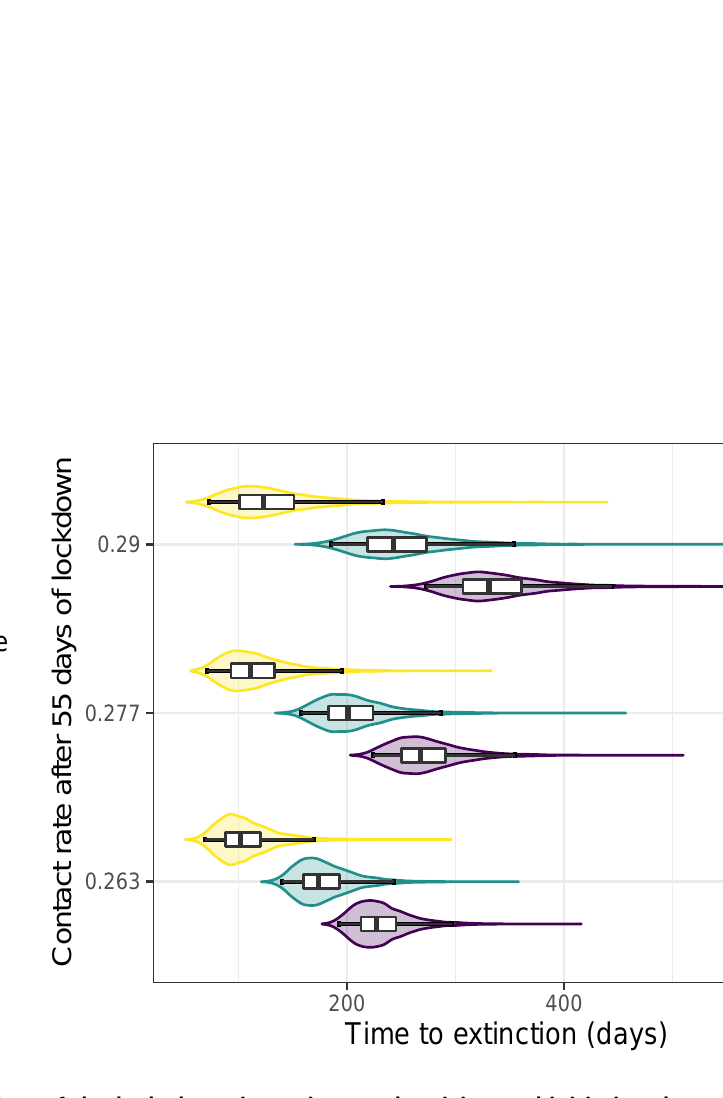
Figure S8 – Effect of the lock-down intensity, stochasticity, and initiation date on the time to extinction ( τ ) without individual spreading heterogeneity assumption. The dis- tributions of the time to extinction (in days since the start of the lock-down) for several contact rate restrictions post 55 first days are plotted on the Y-axis using violin plots and boxplots. In this graph we assume there is no individual spreading heterogeneity. The colors indicate the different initiation date of the lock-down: in purple it starts on Feb 17, green Mar 03 and yellow on Mar 17 (official start). The box extends from the lower to upper quartiles of the data. The whiskers expand from the 2.5% to the 97.5%